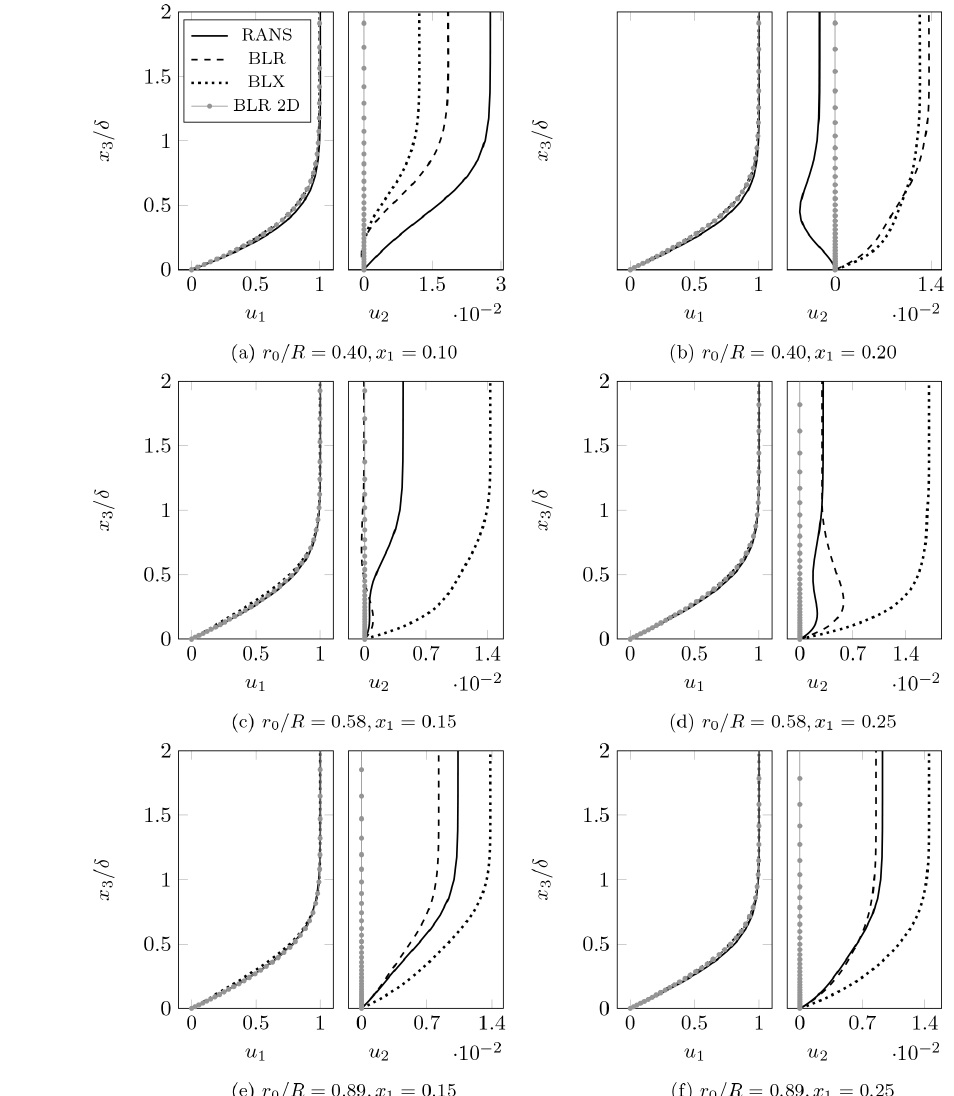
Figure 7. Boundary-layer profiles for Geometry